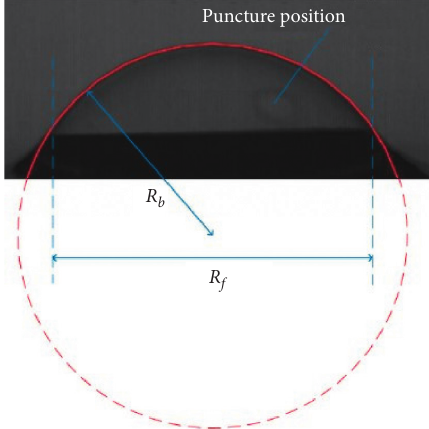
Figure 2: Definition of bubble cap film diameter and bubble